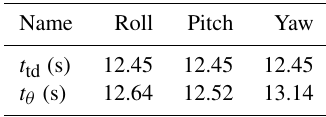
Table 5. Transition time parameters of the